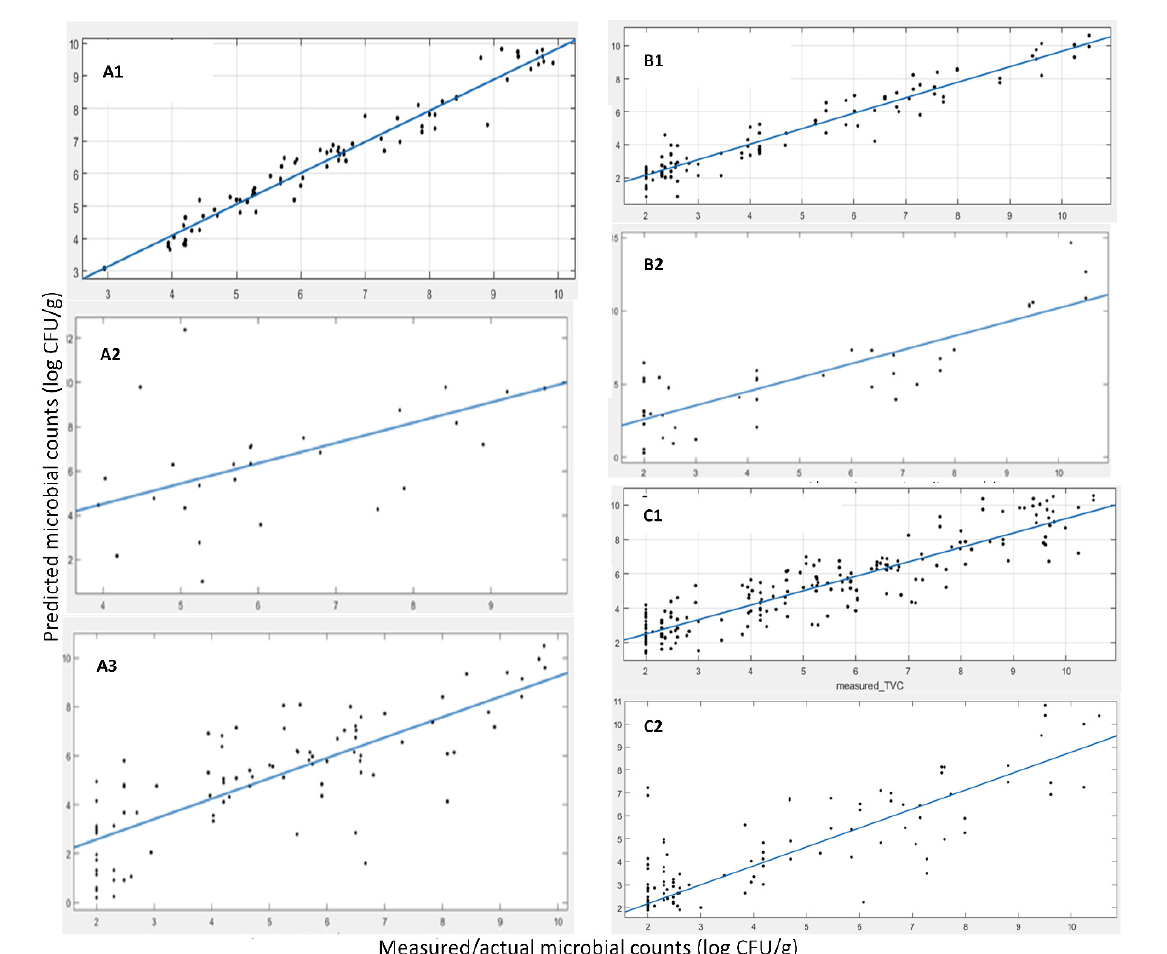
Figure 3. Linear regression between the predicted and the measured microbial counts using FT-IR data. (A1) cross validation MI samples, (A2) test/external validation from harvest 2019 and 2020 MI samples, (A3) test/external validation from harvest 2019, 2020 and 2021 MI samples, (B1) cross validation SAMS samples, (B2) test/external validation SAMS samples, (C1) cross validation, (C2) test/external validation MI+SAMS samples. Table 4. Linear regression fit parameters between actual and predicted TVC values for the different datasets ( A. esculenta MI, SAMS, MI+SAMS) obtained from FT-IR analysis. FT-IR MI